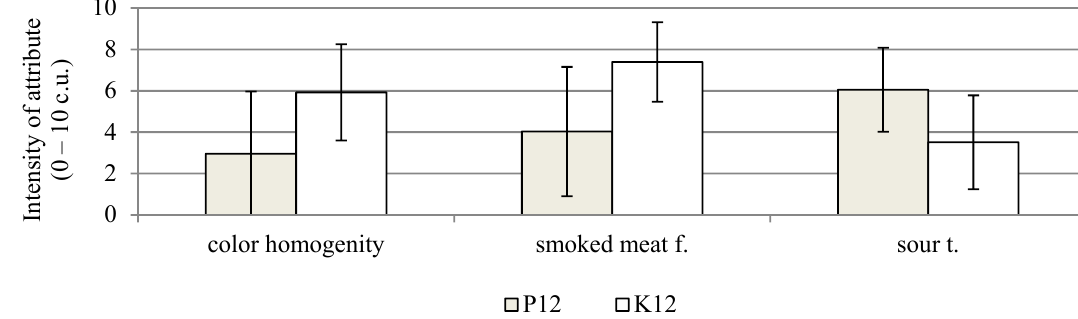
Figure 4. Significant differences in sensory attributes between dry fermented sausages with (P12) and without (K12) L. rhamnosus LOCK900 addition after 12 weeks of storage; ( α ≤ 0.05); abbreviations as at Figure 1.